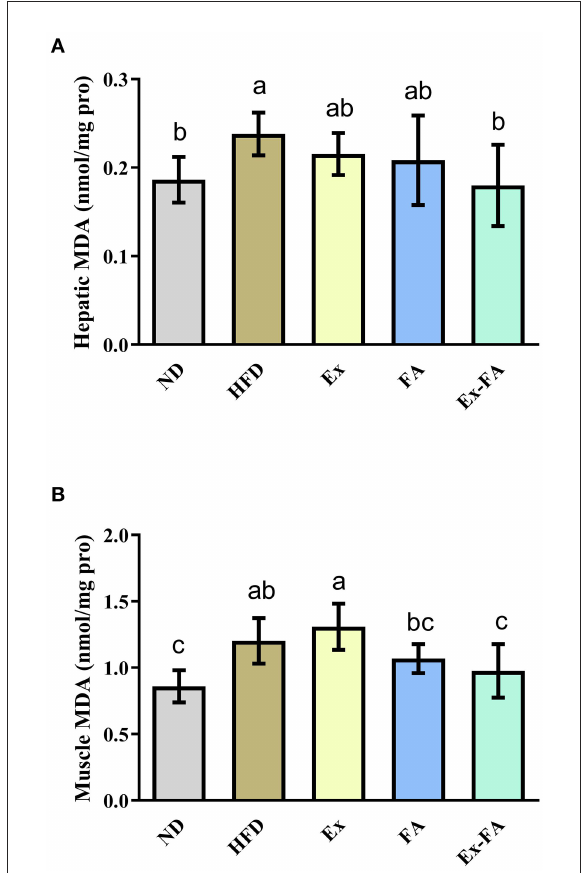
FIGURE5 Effects of Ex, FA, and Ex-FA on the MDA level in the liver (A) and skeletal muscle (B) of HFD-fed mice. ND, normal diet group (control); HFD, high-fat diet group (model); Ex, high-fat diet with exercise; FA, high-fat diet with ferulic acid; Ex-FA, high-fat diet with exercise and ferulic acid. Data are expressed as mean ± SD ( n = 10 for liver and n = 9 for muscle). Means with different letters are significantly different ( P <